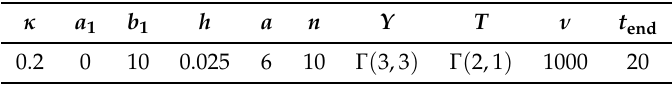
Table 1. Set of parameters used in the first